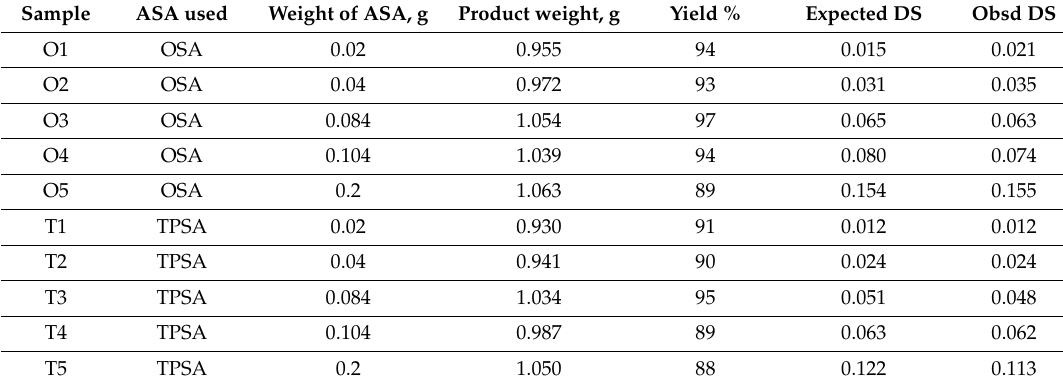
Table 2. Reactions of 1 g cashew gum (CG) with alkenyl succinic anhydride (ASA) in 4 mL DMSO at 120 ◦ C with a 3 h reaction time.